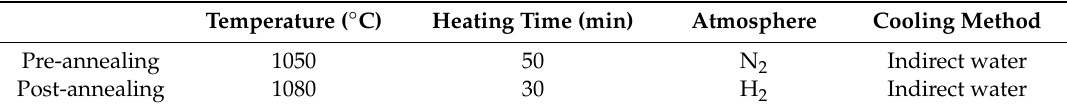
Table 3. Pre-annealing and post-annealing process conditions.